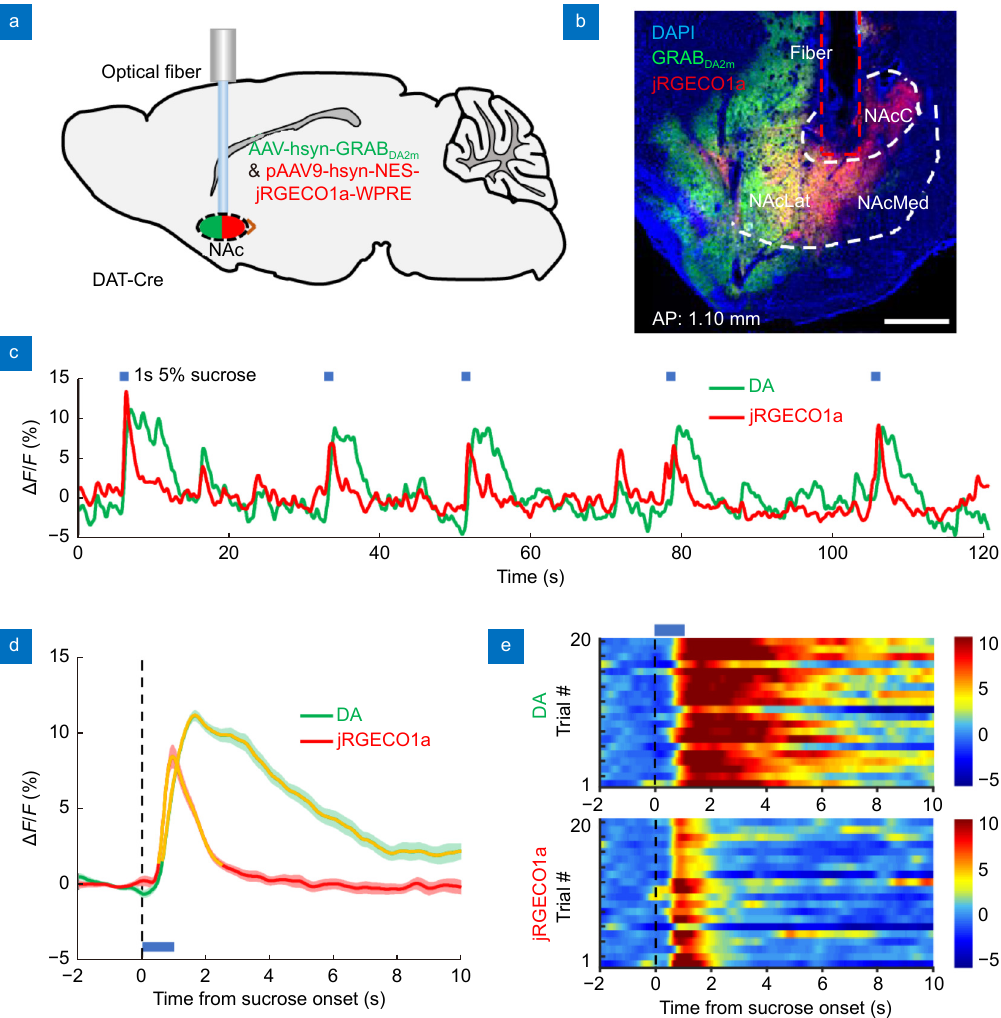
Fig. 5 | Simultaneous recording of dopamine dynamics and neuronal Ca 2+ signals in the NAcLat of a freely moving mouse. ( a ) Schemat- ic diagram of dual-color recording surgery: we simultaneously record the DA signals (GRAB DA2m , green) and the neuronal activity (jGRECO1a, red) in response to a 1 s unexpected sucrose solution in the NAcLat of a freely moving mouse. ( b ) Histology confirming GRAB DA2m (green) and jRGECO1a (red) co-expression in the NAcLat (GRAB DA2m : Ex 450 nm, Em 525 nm; jGRECO1a: Ex 561 nm, Em 590 nm). The brain slice is 1.1 mm anterior to the bregma. Scale bar, 500 μm. ( c ) Representative trace of DA signals and neuronal Ca 2+ signals simultaneously acquired (en- compassing five sequential trials) during the sucrose delivery experiment. The onset times of 5% sucrose solution delivery are indicated above the trace with blue bars. ( d ) Averaged DA signal and neuronal Ca 2+ signal transients in response to unexpected sucrose solution. The shaded area represents the SEM (±). The blue bar represents the 1 s sucrose solution. Orange segments indicate a statistically significant increase from the baseline (* P <0.05, Wilcoxon’s signed-rank test; n = 20 pairs, one mouse). ( e ) Heatmap of DA signal and neuronal Ca 2+ signal transients, aligned to the onset time of sucrose solution delivery. Each row in the heatmap indicates the data for one behavioral trial; 20 trials are plotted. The blue bar represents the delivery of a 1 s sucrose solution. Abbreviations: DA, dopamine; NAc, nucleus accumbens; NAcC, nucleus accum- bens core; NAcLat, nucleus accumbens lateral shell; NAcMed, nucleus accumbens medial